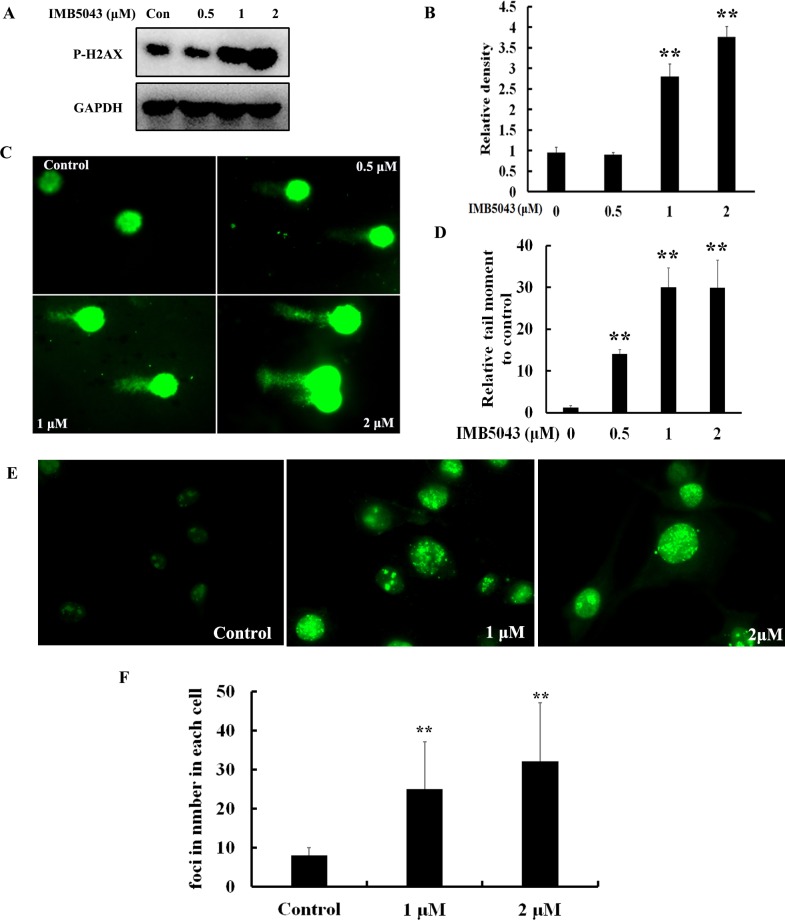
IMB5043 leads to cell DNA breakage, γ-H2AX foci formation.(A). p-H2AX was up-regulated by IMB5043 detected by Western blot. SMMC-7721 cells were treated with indicated doses of IMB5043 for 24 hours. (B). Quantification of p-H2AX expression treated with IMB5043 in SMMC-7721 cells. Data shown is means ± SD. **P<0.01. (C). Comet electrophoresis assays were performed to detect the DNA double strand breaks. SMMC-7721 cells were treated with indicated doses of IMB5043 for 6 hours. (D). Quantitative analysis of relative tail moment was performed with the comet analysis software. Data shown is means ± SD. **P<0.01. (E). γ-H2AX immunofluorescence foci was tested with γ-H2AX antibody conjugated with FITC. SMMC-7721 cells were treated with indicated doses of IMB5043 for 24 hours. (F). Quantification of γ-H2AX foci. Data shown is means ± SD. **P<0.01.